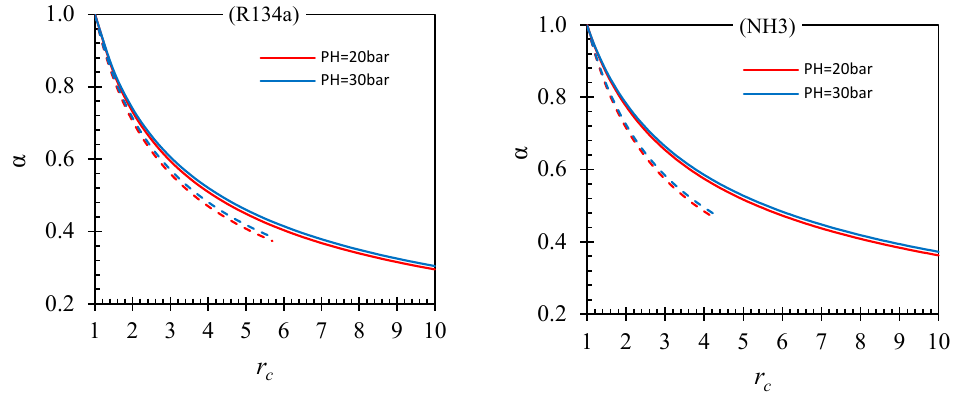
Figure 10. Efficiency of the driving R134a ( left ) and ammonia ( right ) use as a function of the compressor pressure ratio; solid lines—adiabatic compression, dashed lines—isothermal compression.